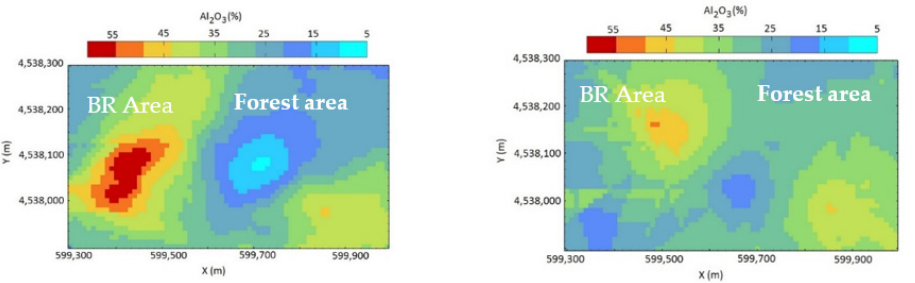
Figure 10. Concentration maps of Al 2 O 3 (%) from co-kriging estimation using the data from PRISMA ( left ) and Sentinel-2 ( right ).